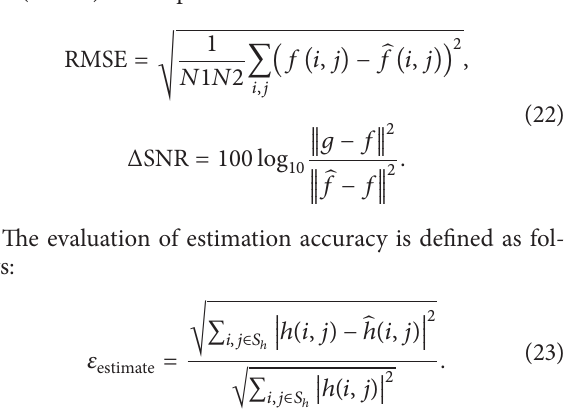
values among three